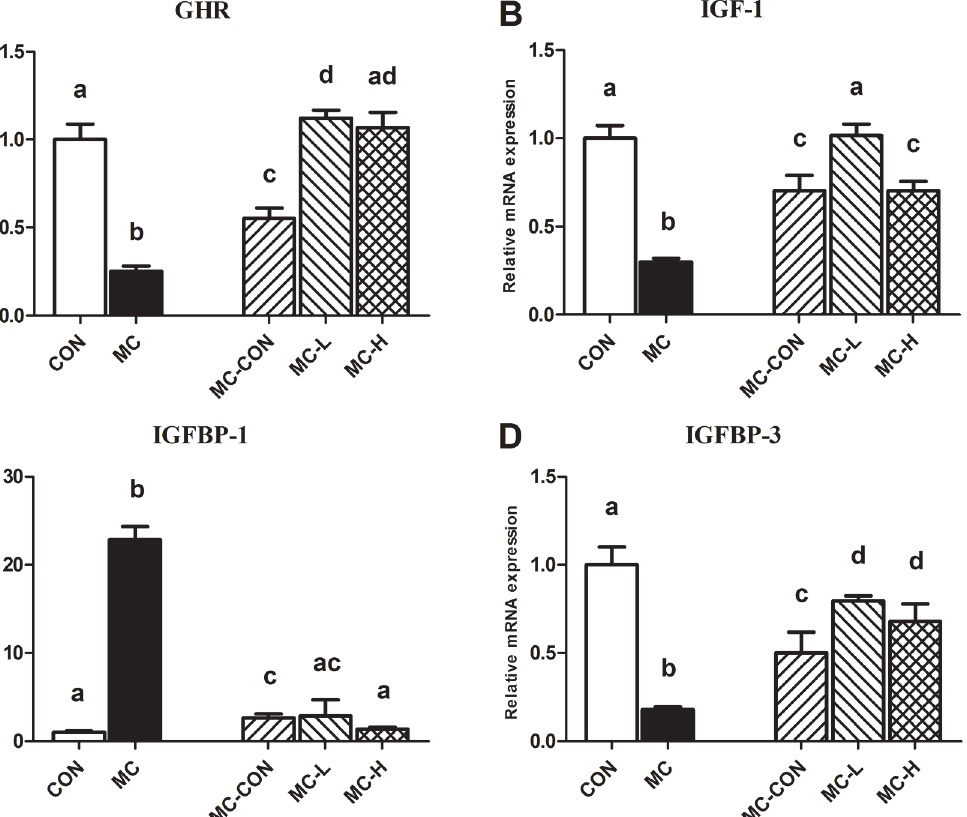
Fig 4. Hepatic Expression of GHR, IGF-1, IGFBP-1, and IGFBP-3 mRNA. GHR (A), IGF-1 (B), IGFBP-1 (C), and IGFBP-3 (D) mRNA levels in each group were measured by real-time quantitative reverse transcriptase (RT)-PCR. Values are presented as means ± standard deviation (SD). Different letters indicate a significant difference (p < 0.05). GHR, growth hormone receptor, IGF-1, insulin-like growth factor-1, IGFBP-1/-3, insulin-like growth factor binding protein-1/-3.